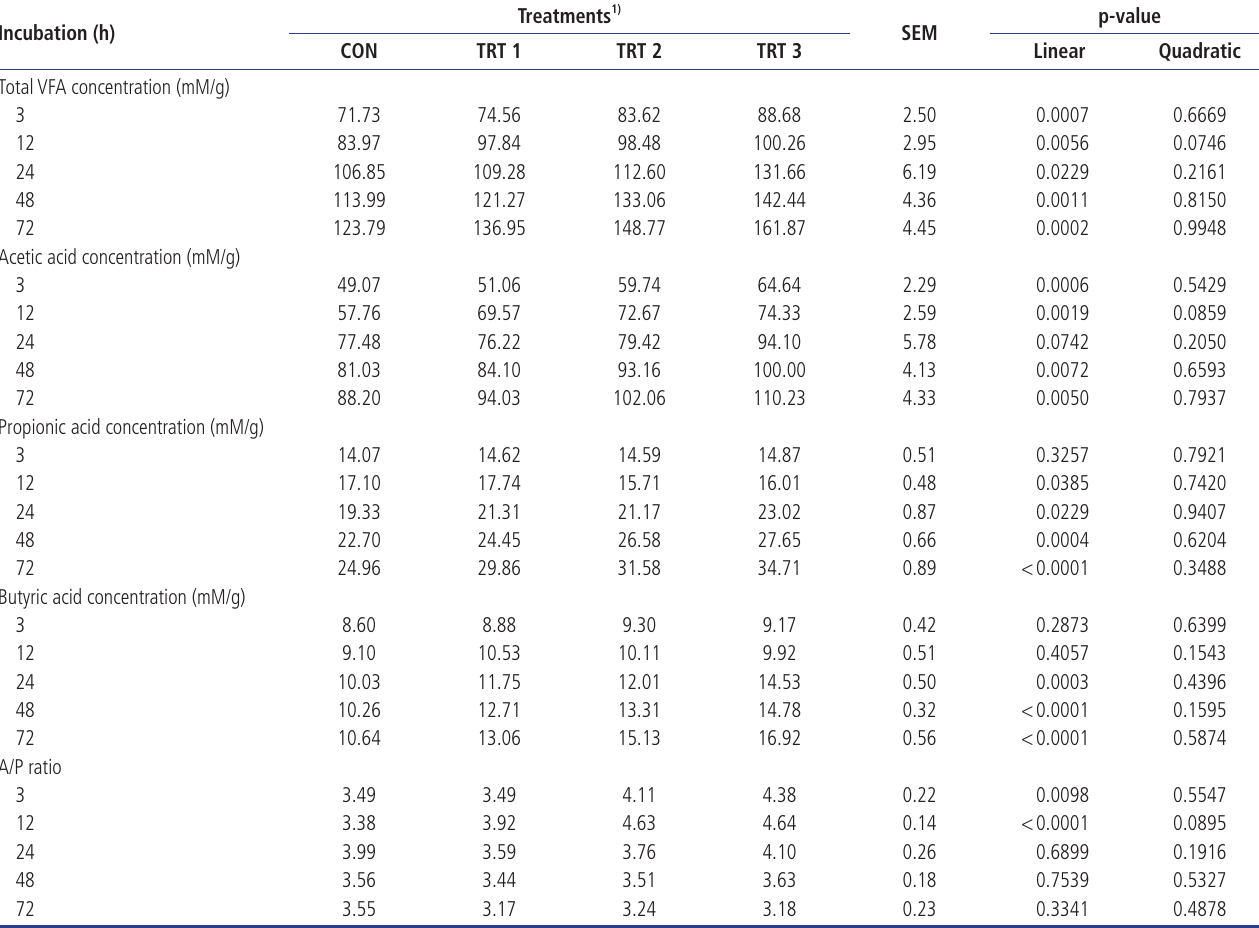
Table 3. Effect of Gelidium amansii extract on total volatile fatty acids (VFA), acetic acid, propionic acid, butyric acid and acetic acid/propionic acid (A/P) ratio by mixed rumen microbial fermentation Incubation